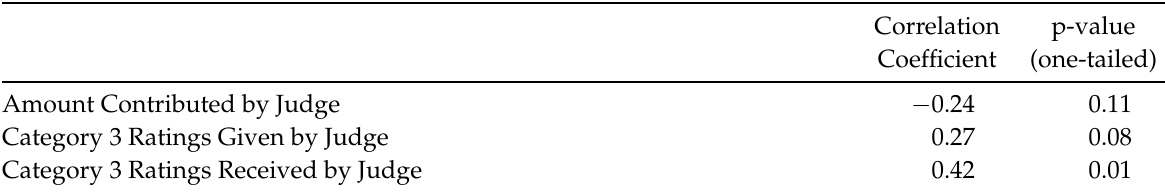
Table 6: Correlation of individual accuracy rates and selected